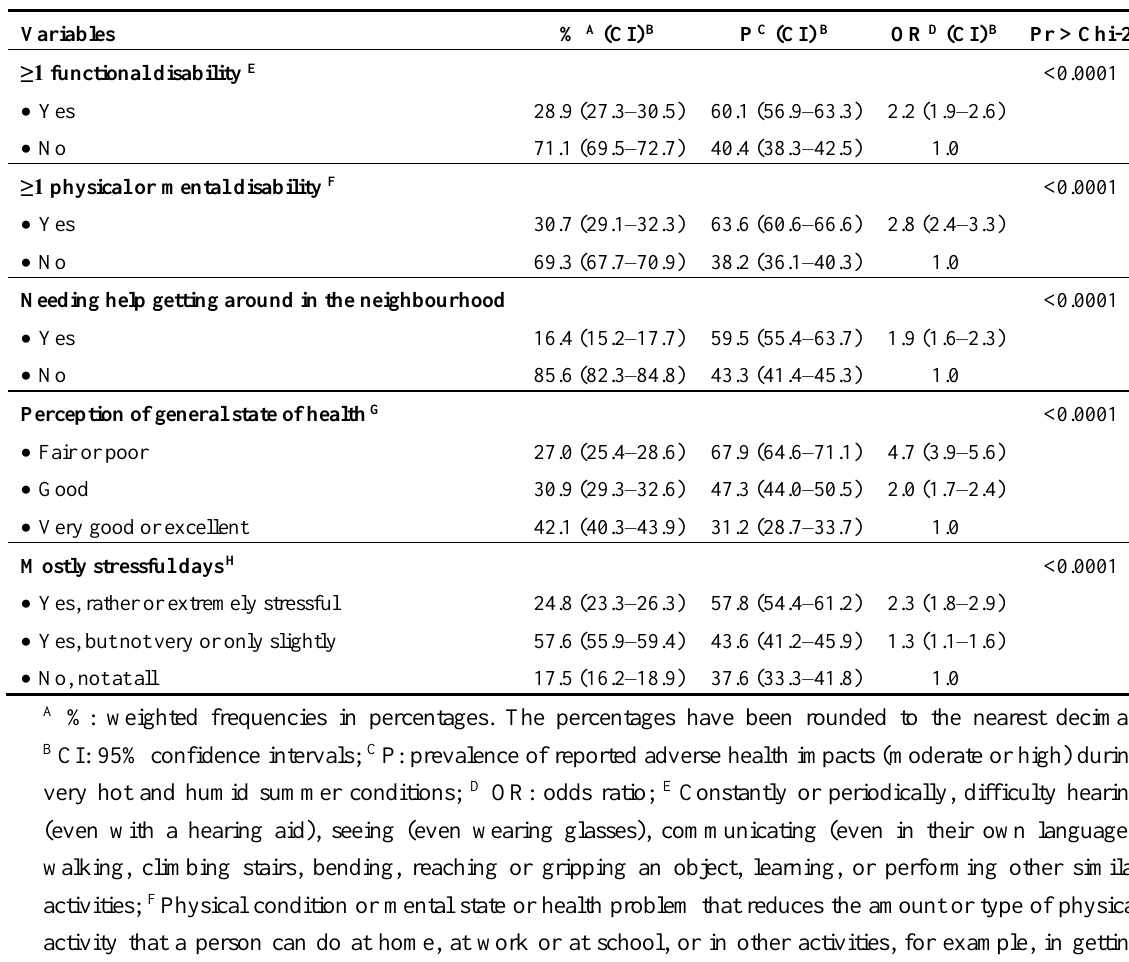
Table 5. Prevalence of reported adverse health impacts, very hot and humid summer conditions, based on disabilities, the need for help getting around in the neighbourhood and health-related